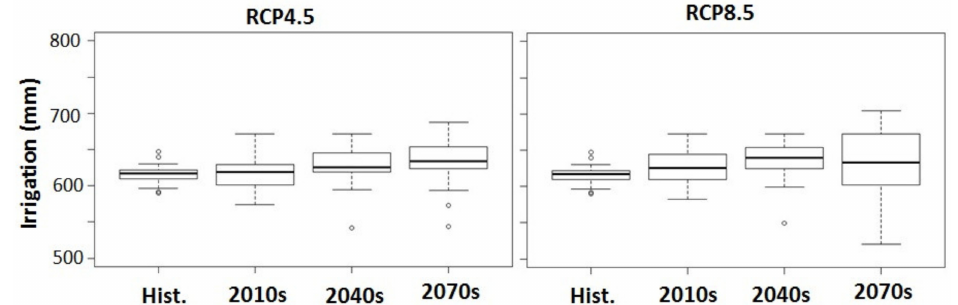
Figure 10. Percentage (%) change of irrigation during the cropping period (June-September) in the Jeonju metrological station area for the 2010s (2nd column), 2040s (3rd column), 2070s (4rd column) considering RCP4.5 ( left side ) and (2) RCP 8.5 ( right side ) scenarios relative to the historical period (1st column) considered as baseline